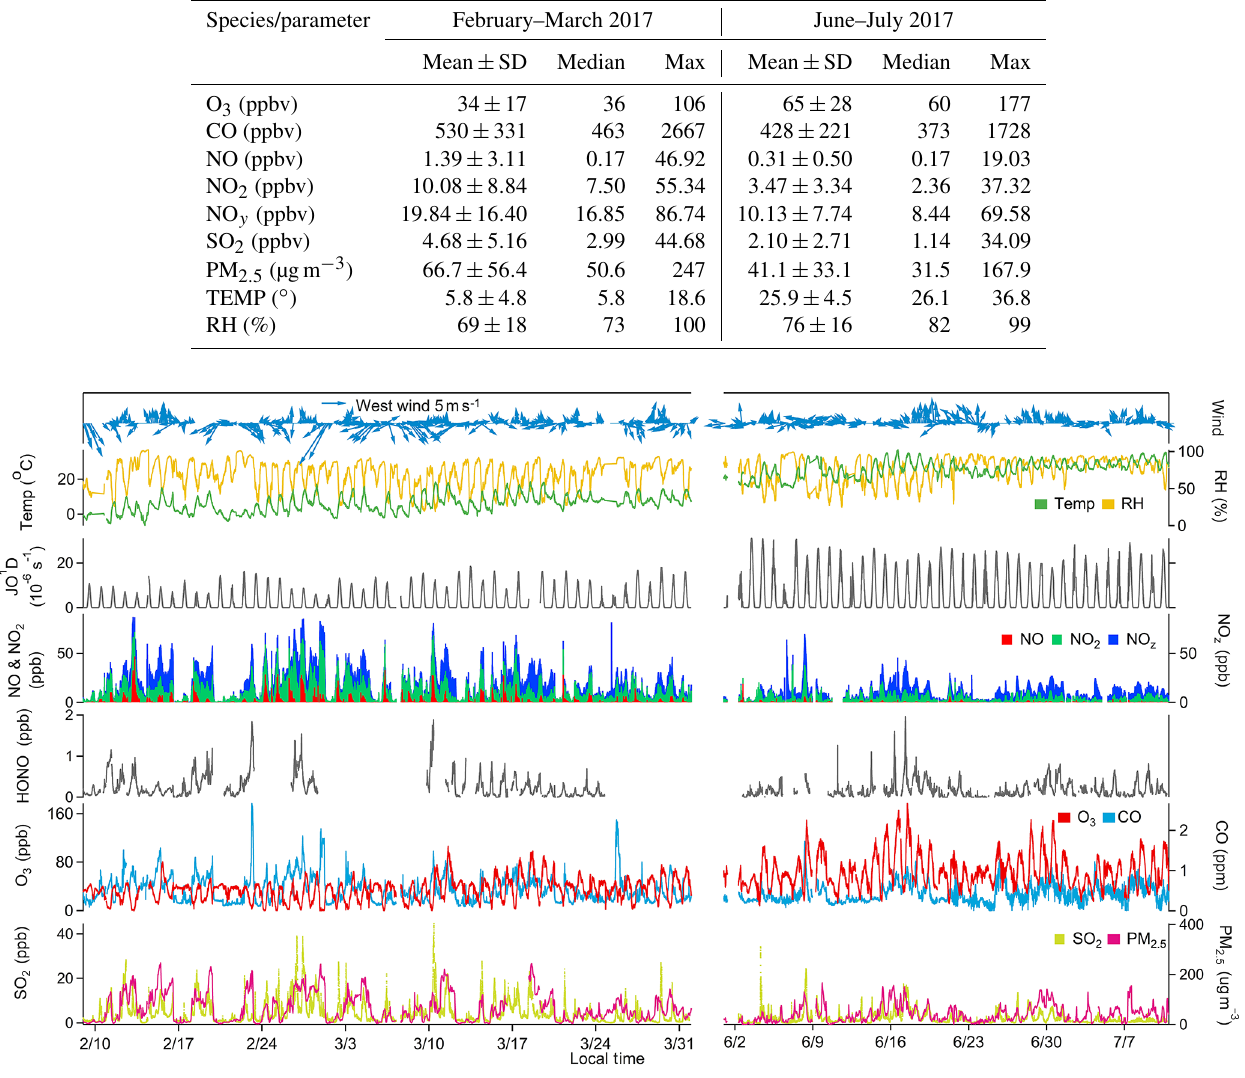
Table 1. Descriptive statistics of hourly concentrations of trace gases, PM 2 . 5 , and meteorological parameters at the rural site in the YelRD region.